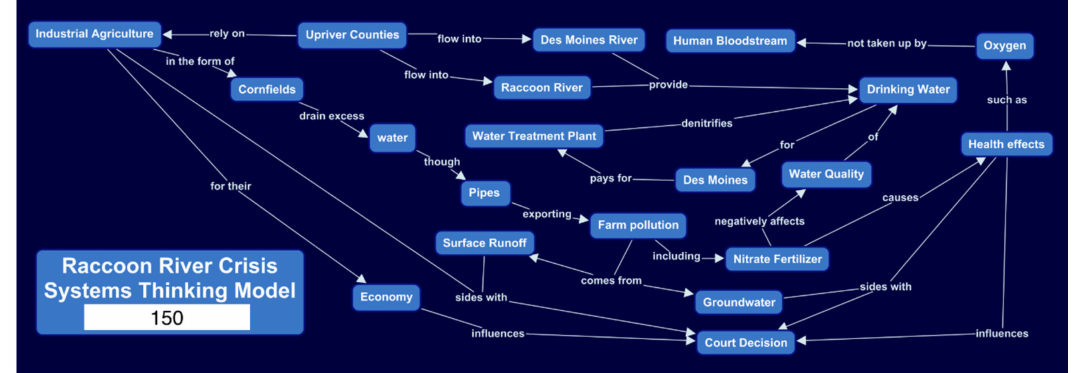
Figure 2. Students’ most often included system components in their